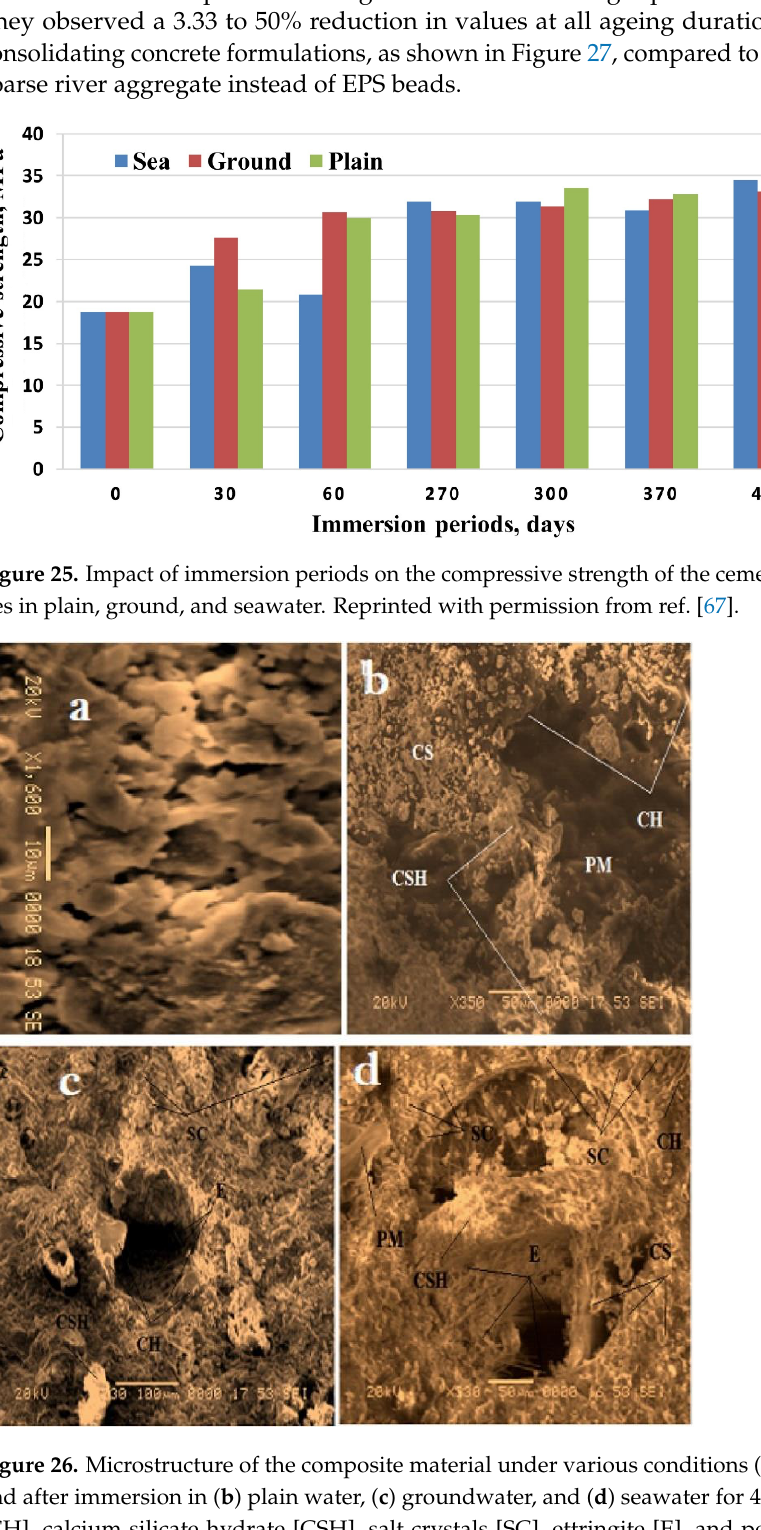
No Figure 24. Types of samples used in the single flame source test. Reprinted with permission from ref. [66].